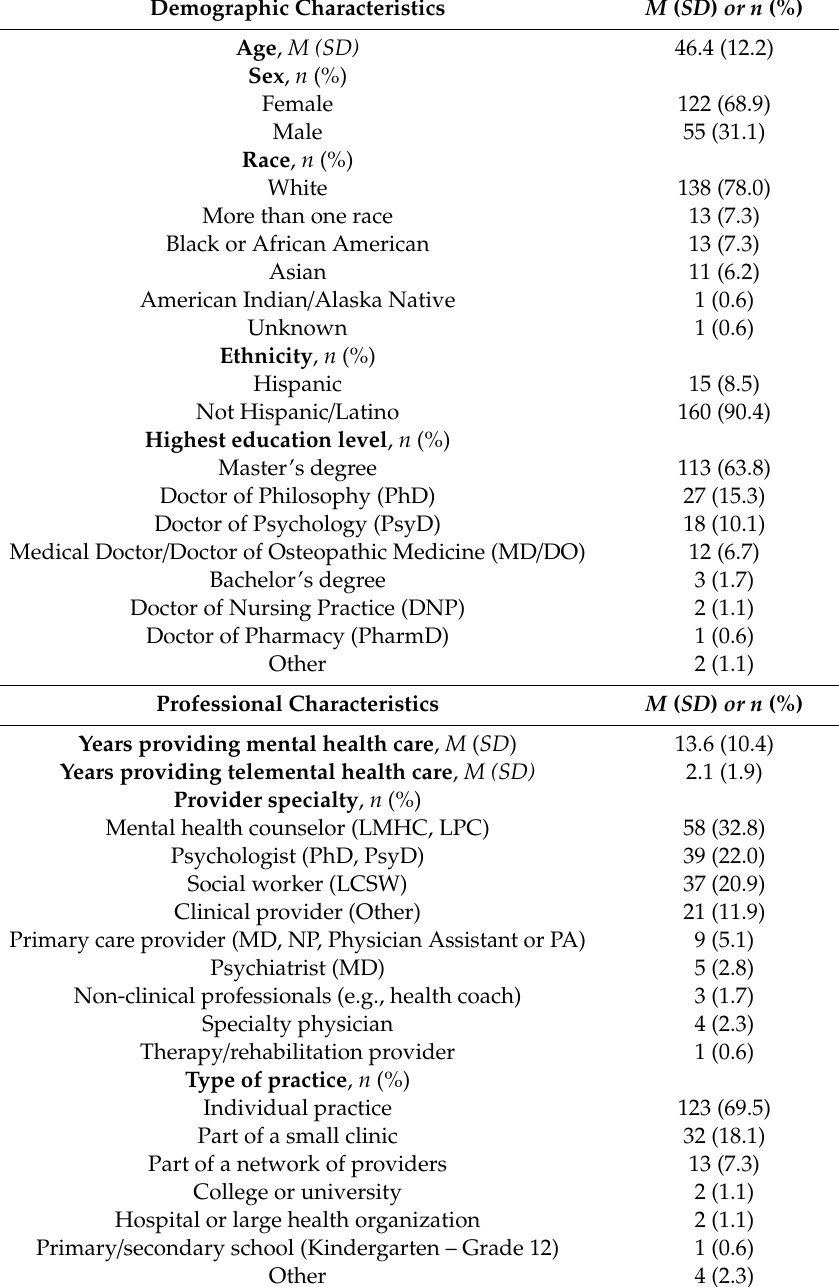
Table 1. Characteristics of telemental health providers, N =